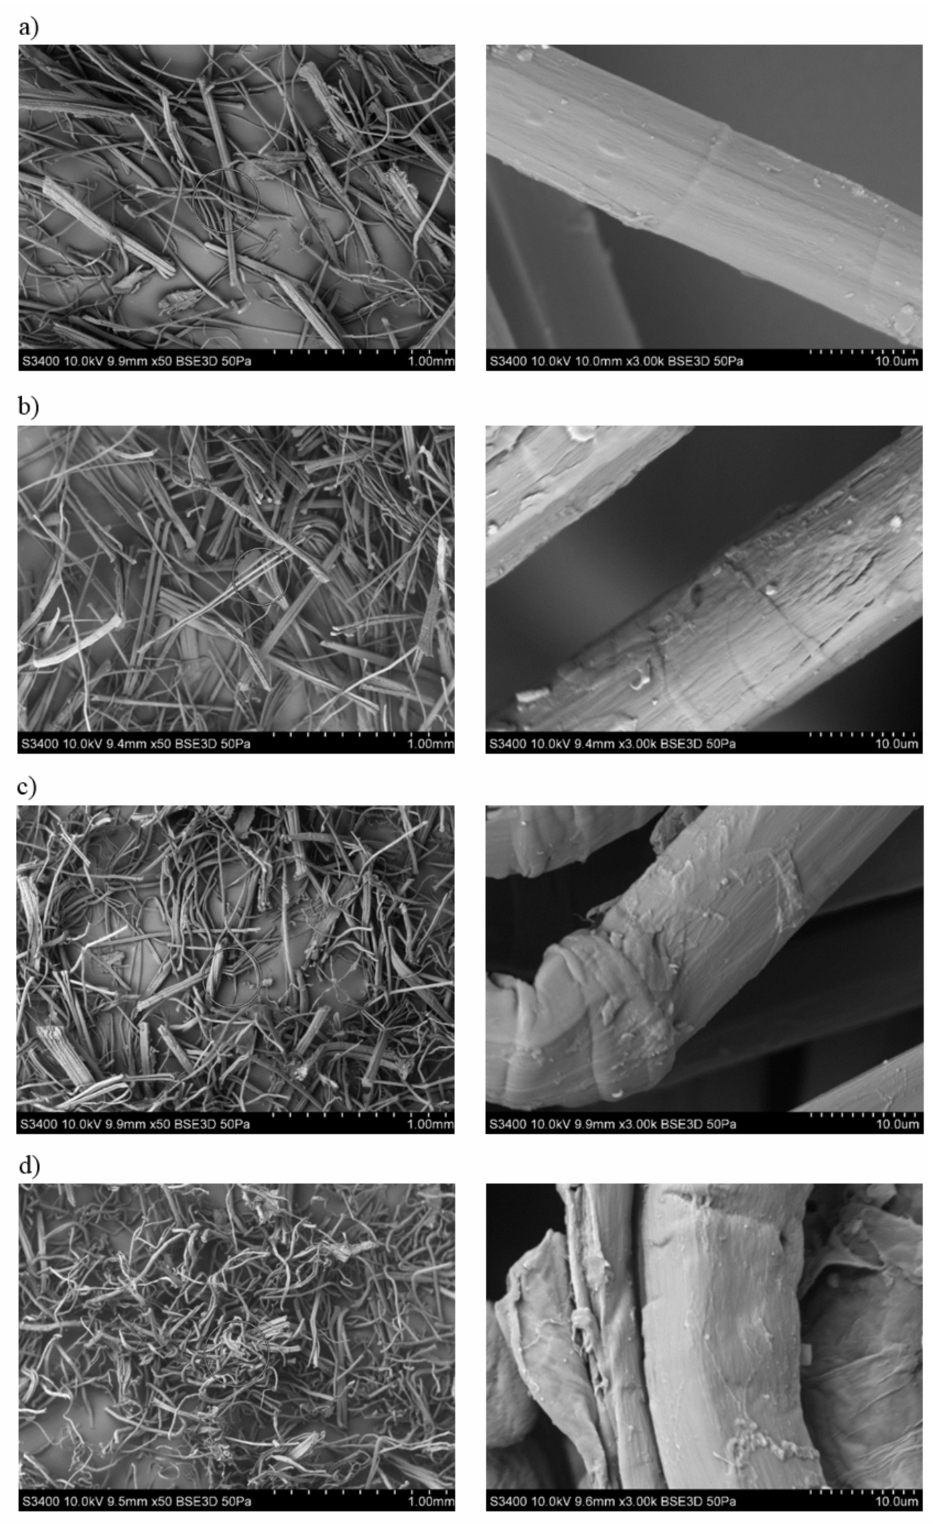
Figure 4. SEM photographs of flax fibers: ( a ) unmodified, ( b ) alkalized by 2% NAOH solution, ( c ) alkalized by 5% NAOH solution, ( d ) alkalized by 10% NAOH